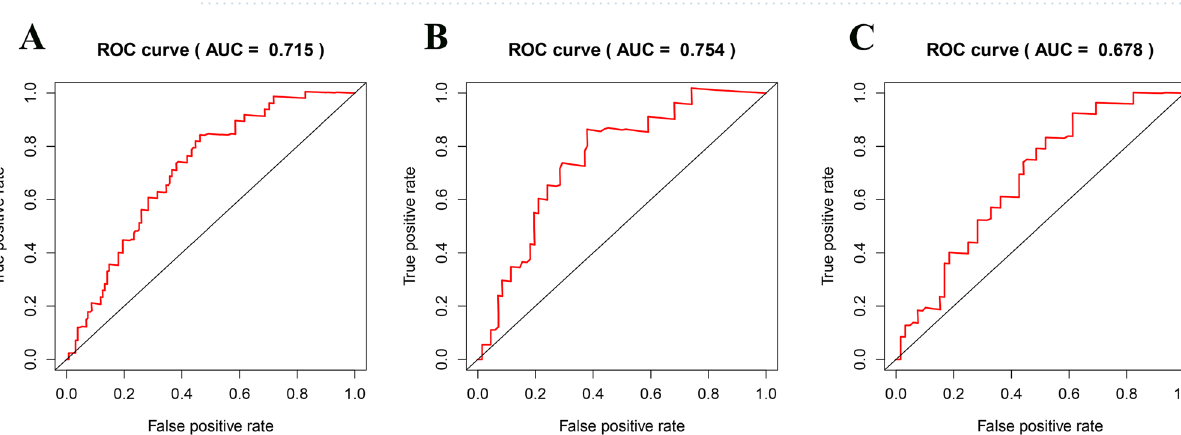
Figure 4. Kaplan–Meier analysis for the 7-immune-related prognostic miRNA signature in PC. ( A ) KM analysis in the the whole set; ( B ) testing; ( C ) training set.